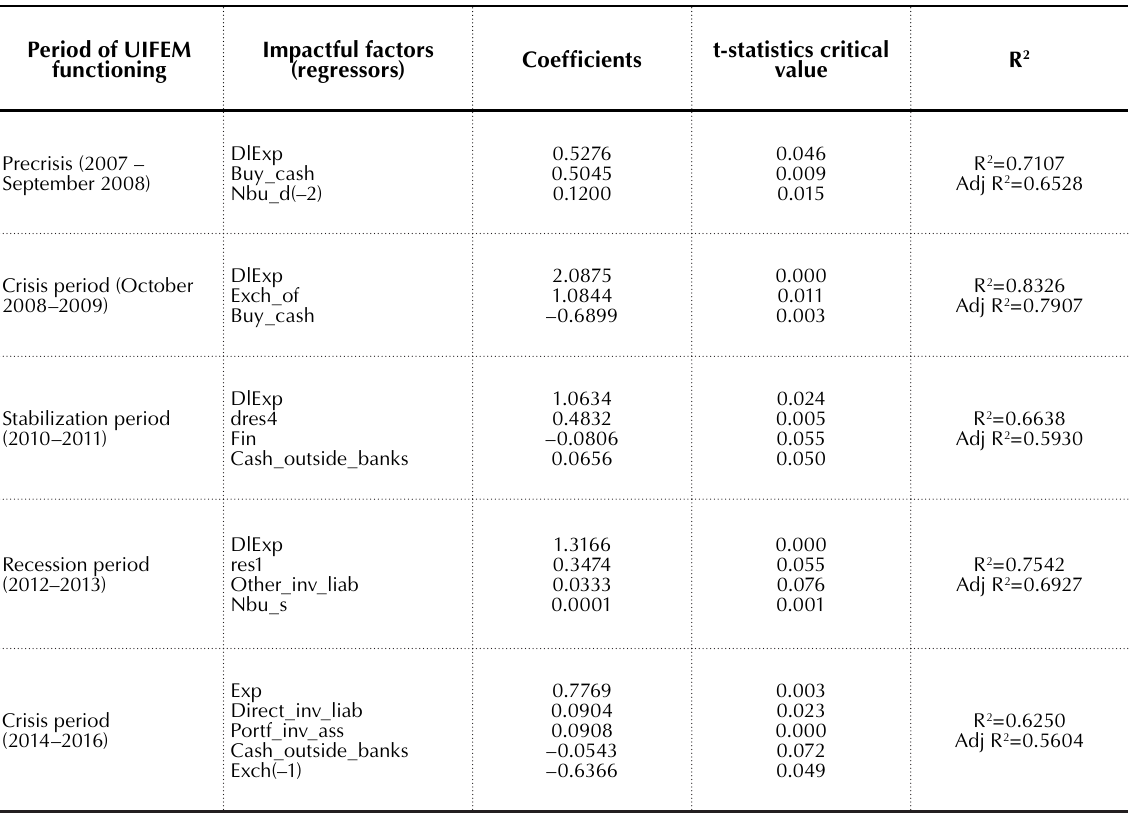
Source : estimated by the